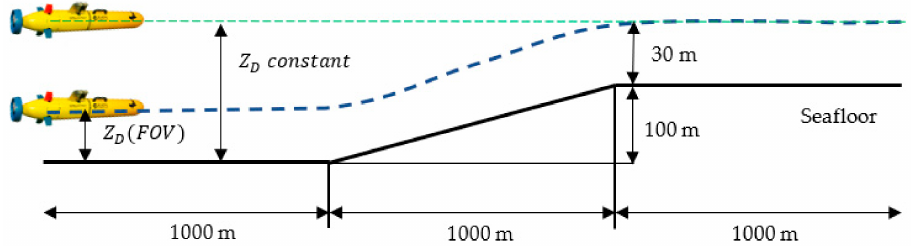
Figure 9. Modelling of the seafloor.